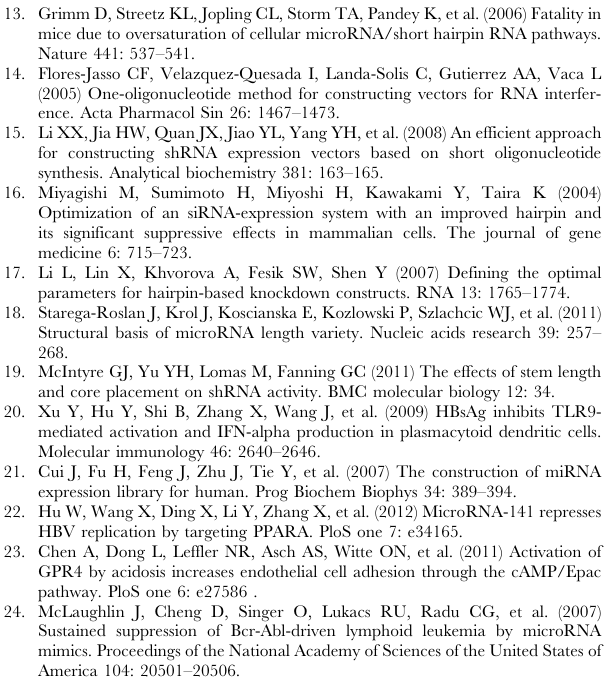
target sequence ‘‘UCUGUUUGCCCUGAUCUGCAU’’ were used in (A) and (B) respectively. Statistical significance was determined by comparing to shRNAs groups AS1856 and ASGluc-1 respectively. (TIF) Figure S5 Transfection with shRNA vectors didn’t induce an obvious interferon response. Lane 1, mock; lane 2, IFN a -2a; lane 3, AS139; lane 4, AS1819; lane 5, AS3172; lane 6, neg. (TIF) Figure S6 An indirect experiment using the 3’-UTR luciferase assay to demonstrate that these shRNAs were expressed. The relative luciferase level of AS139-1819-3172 was compared with AS139, AS1819 and AS3172 respectively. (TIF) Figure S7 The co-transfected multiple shRNA con- structs had better silencing activity than the shRNA plasmid with multiple shRNAs when the same amount of each shRNA scaffold was used. (TIF) Data S1 The typical sequencing data covering the shRNA expression element, the full pshOK-basic plas- mid sequence and their alignment file.